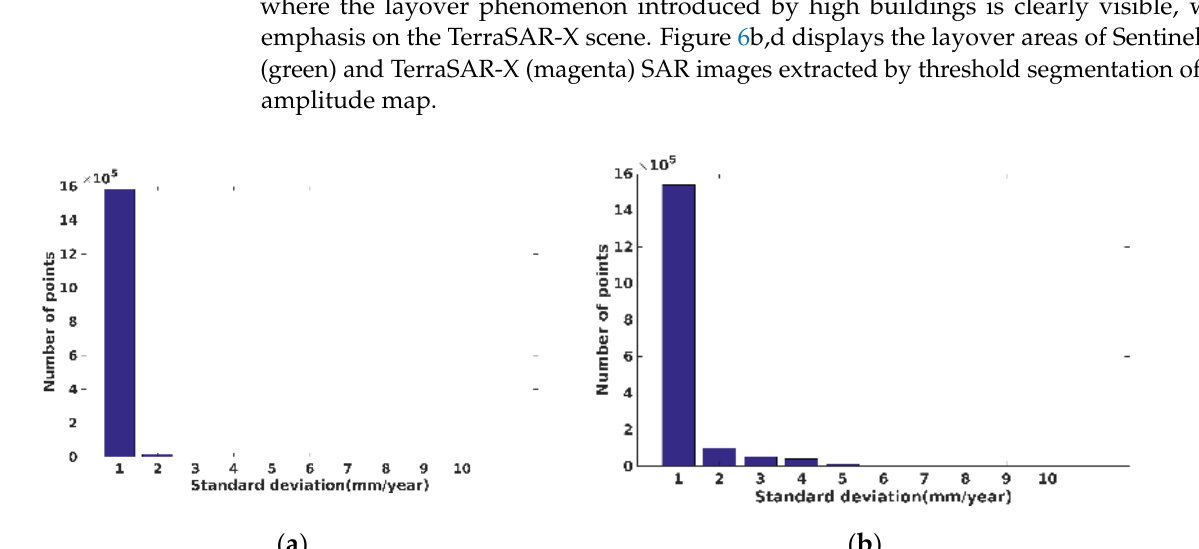
Figure 5. Distribution of the standard deviation of land subsidence rates: ( a ) Sentinel-1A recordings; ( b ) TerraSAR-X recordings.